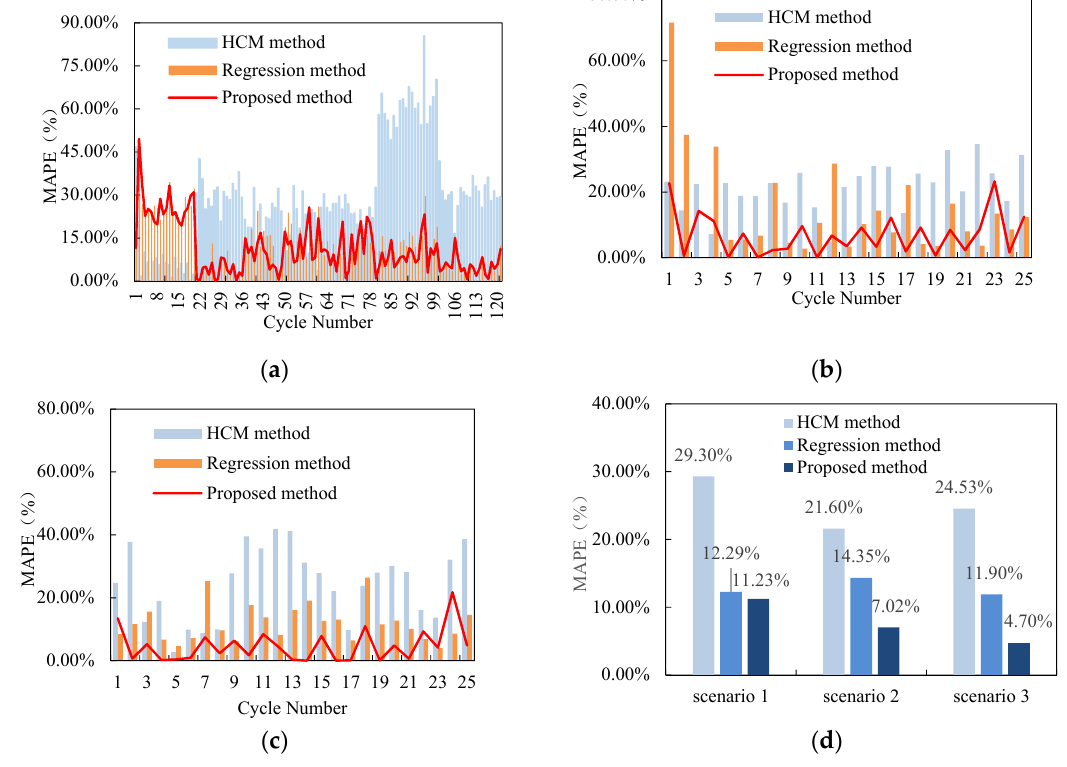
Figure 9. Comparison of the predicted accuracy with HCM, regression and Neural Network methods: ( a ) error distributions of three models in scenario 1; ( b ) error distributions of three models in scenario 2; ( c ) error distributions of three models in scenario 3; ( d ) the mean absolute percentage error (MAPE) of estimation saturation flow rates for three models.